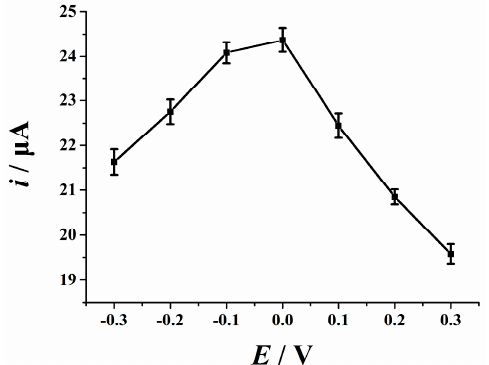
Figure 8. The effects of accumulation time on the oxidation of 10 μ M vanillin in 0.1 M H 2 SO 4 solution at Cu 2 O NPs-ERGO/GCE. Accumulation potential: 0.0 V, scan rate: 0.1 V s − 1 . Error bars represent SD, n = 3.